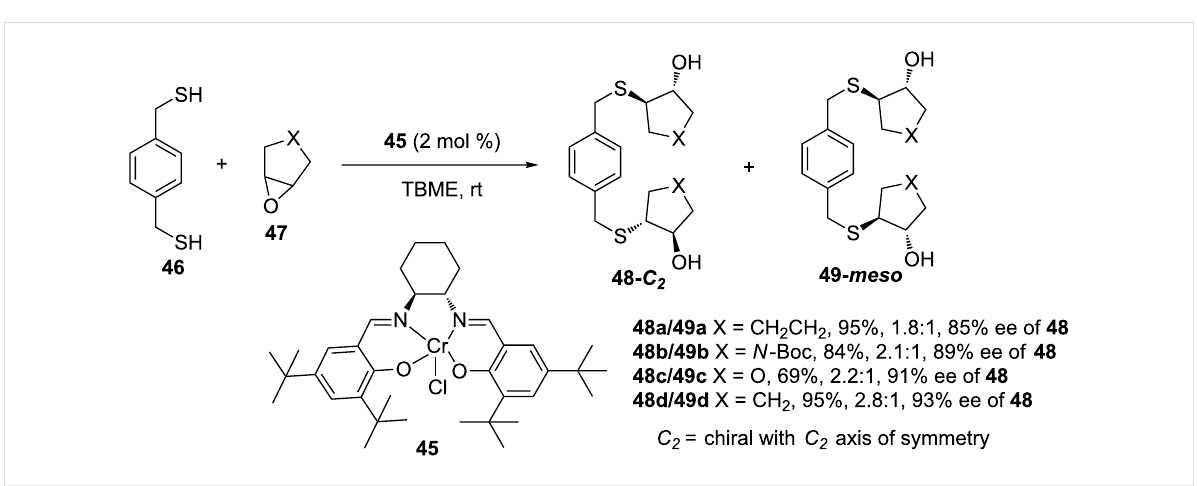
Scheme 13: Asymmetric ring opening of meso -epoxides by p -xylenedithiol catalyzed by a ( S,S )-(salen)Cr complex.